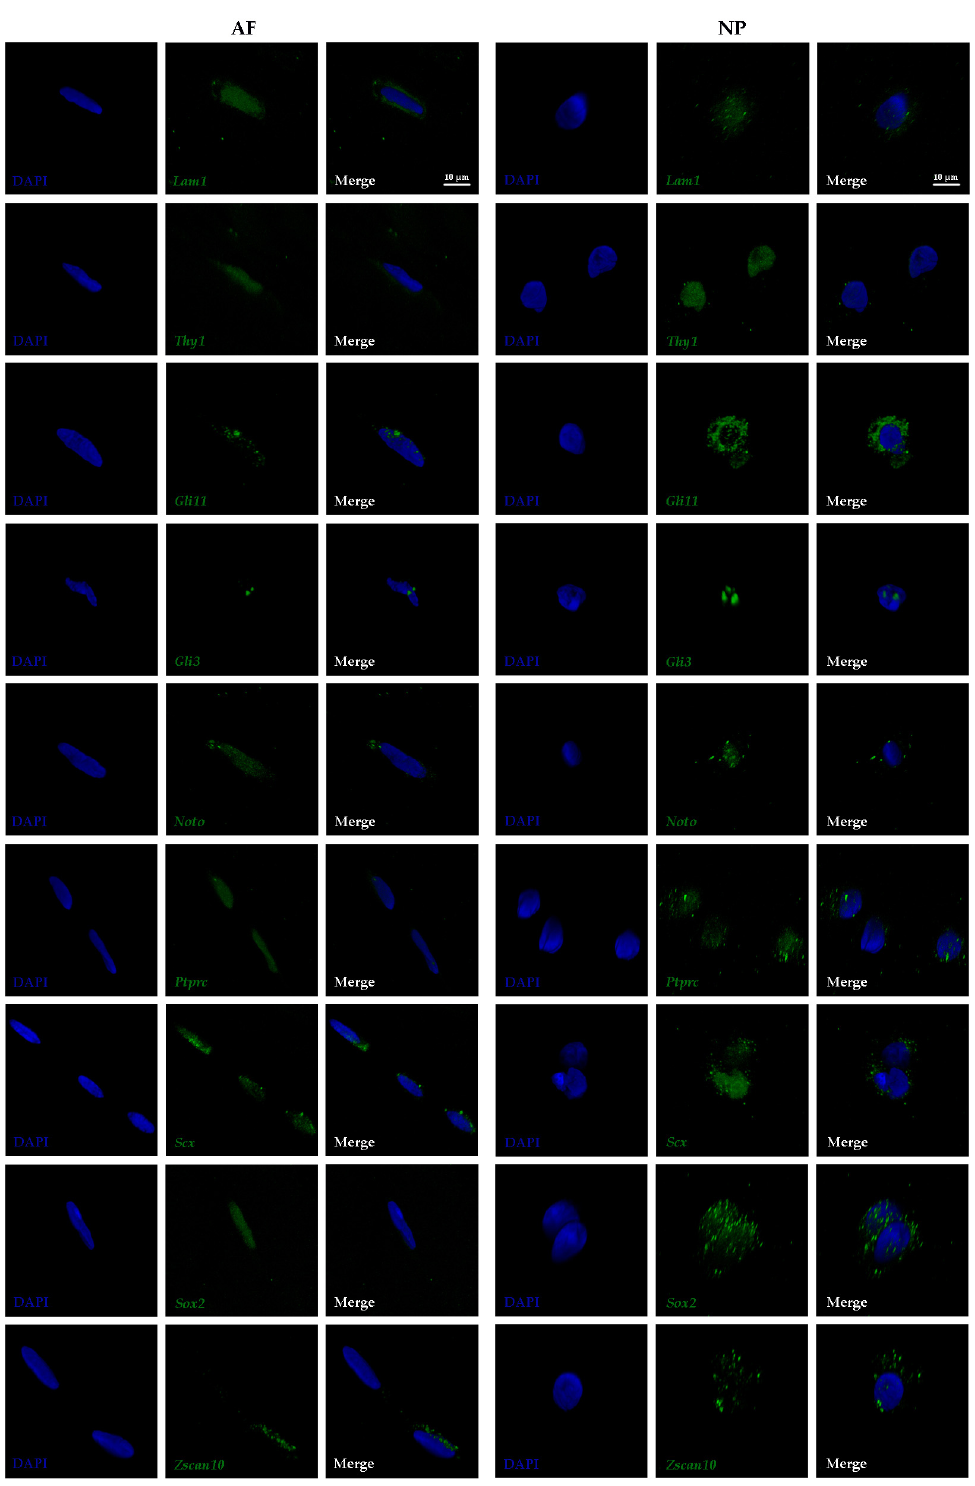
Figure 2. Fluorescent RNA in situ hybridization (FL-RISH) showing the transcripts (green) of nine proposed biomarkers with subcellular resolution in the outer AF and NP of a mature bovine intervertebral discs (IVD) at 63 × magnification and zoom factor 3. Nuclei are visualized with DAPI (blue). Laminin1 ( Lam1 ) ; Thymocytedifferentiationantigen1( Thy1 ); Glioma-associatedoncogene1( Gli1 ); Glioma-associated oncogene 3 ( Gli3 ); Notochord ( Noto ); Tyrosine phosphate receptor type C ( Ptprc ); Scleraxis ( Scx ); Sex determining region Y-box 2 ( Sox2 ); Zinc finger and SCAN ( SRE-ZBP, CTfin51, AW- 1 and Number 18 cDNA) domain containing transcription factor 10 ( Zscan10 ). Scale bar reflects 10 µ